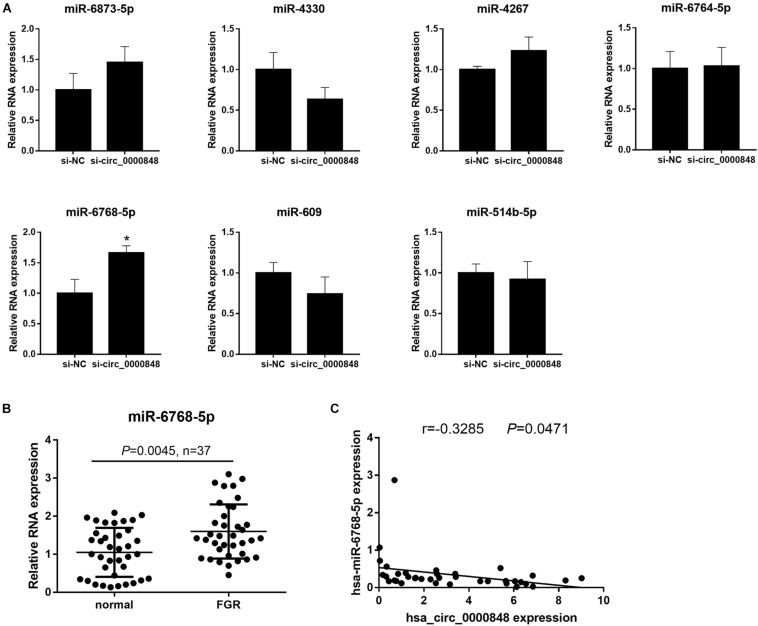
hsa-miR-6768-5p expression is up-regulated in FGR placenta and is negatively correlated with hsa_circ_0000848. (A) Expression of hsa-miR-609, hsa-miR-514b-5p, hsa-miR-6768-5p, hsa-miR-6873-5p, hsa-miR-4330, hsa-miR-4267, and hsa-miR-6764-5p in HTR-8 cells transfected with siRNA targeting hsa_circ_0000848 (si-circ_0000848) or negative control siRNA (si-NC). *P < 0.05 using unpaired t-tests. (B) hsa-miR-6768-5p expression in FGR or normal placental tissues (n = 37). Differences between FGR and normal groups were analyzed using non-parametric tests. (C) Linear regression analysis to analyze the correlation of hsa_circ_0000848 and hsa-miR-6768-5p in FGR placental tissues (n = 37).